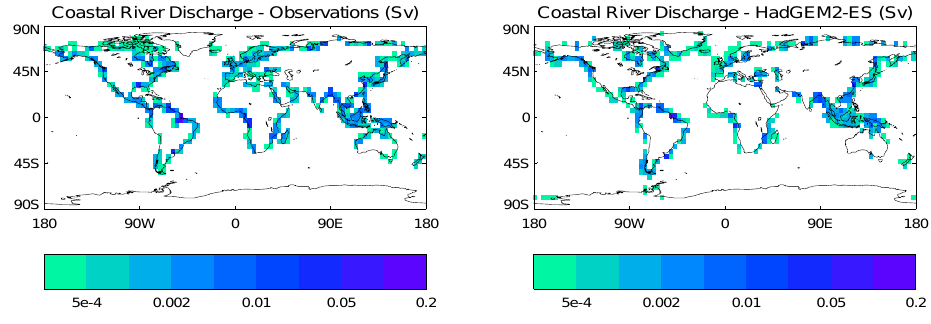
Fig. 7. Mean annual (1948–2004) discharge (Sv) from 4 ◦ latitude by 5 ◦ longitude coastal box estimated from available gauge records and reconstructed river flow (Dai et al., 2009) and simulated discharge from